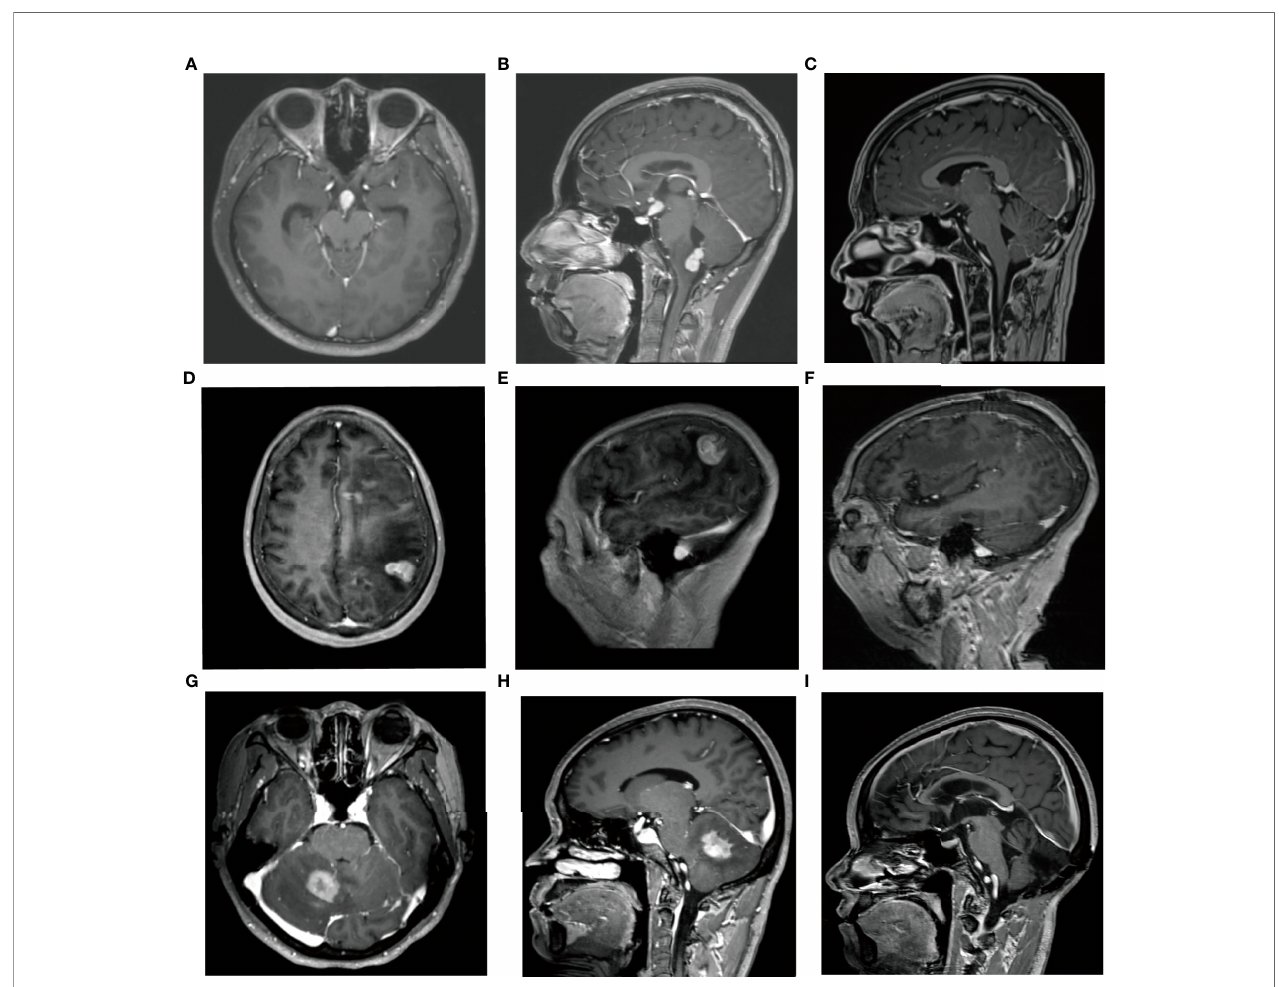
FIGURE 1 | Case 1, male, 16 years old. (A, B) MRI-enhanced images showed homogeneous enhancement of tumors in the dorsal side of the brainstem, around the fourth ventricle, and in the pineal region. (C) Postoperative MRI showed gross total resection of brainstem lesions. (D, E) Case 2, female, 52 years old. Sagittal- enhanced images showed signi fi cantly enhanced tumor masses in the left parietal lobe. (F) The tumor was totally resected. (G, H) Case 38, female, 48 years old, right cerebellar hemisphere aera displayed homogeneous enhancement. (I) Postoperative MRI revealed surgery combined with radiotherapy and chemotherapy obtained a good therapeutic